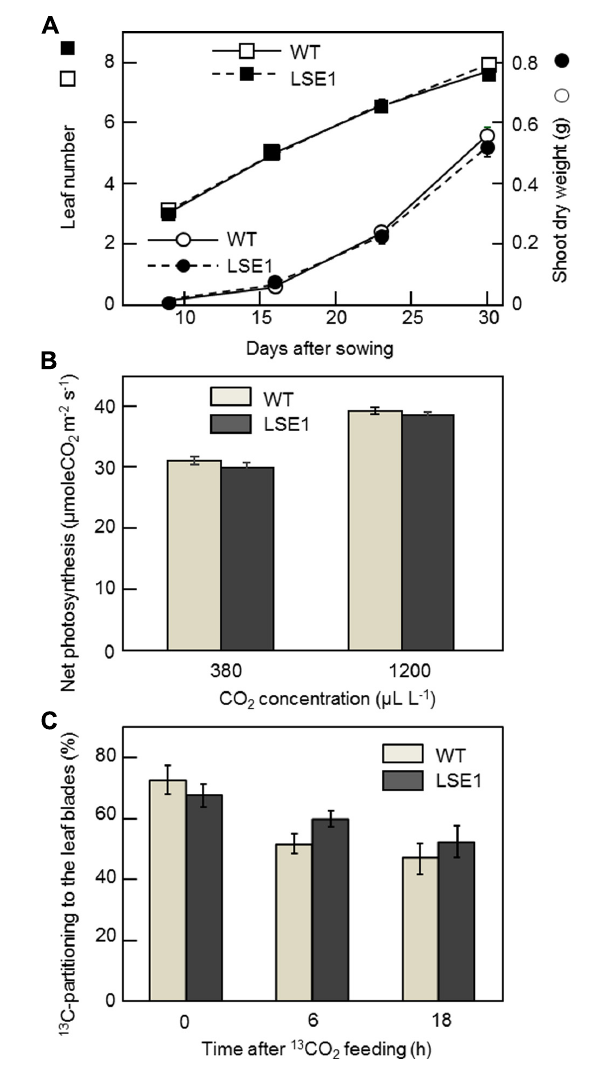
FIGURE 6 | Growth, photosynthesis and 13 C-photoassimilate partitioning in the seedlings of LSE1. (A) The dry weight of the terrestrial portion (circles) and the leaf number (squares) were examined in the seedlings of LSE1 (closed symbols) and wild-type plants (open symbols) during the early vegetative growth stage. Data represent the mean ± SE ( n = 5). (B) Net photosynthesis rates of the uppermost fully elongated 7th leaf blades were measured under CO 2 concentrations of both 380 and 1200 μ L L − 1 . Light intensity was set at 1200 μ mol photon m − 2 s − 1 . Data represent the mean ± SE ( n = 4). (C) Partitioning of 13 C-photoassimilate to the leaf blades was measured immediately (0 h), 6 h, and 18 h after the cessation of 2-h feeding of 13 CO 2 .The seedlings at the 6th leaf stage were used in the experiment. Data represent the mean ± SE ( n = 4).